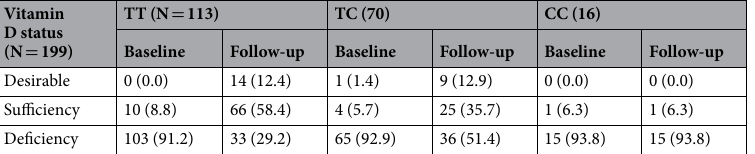
Table 2. Vitamin D status among the Fok-I genotypic groups before and after 12 months of vitamin D supplementation. Note: Σ 2 test showed a P trend of 0.626 at baseline; P trend at 12-month follow-up is < 0.0001. Data is presented as frequencies (%). Deficiency: Serum 25(OH)D level < 50 nmol/l. Sufficiency: Serum